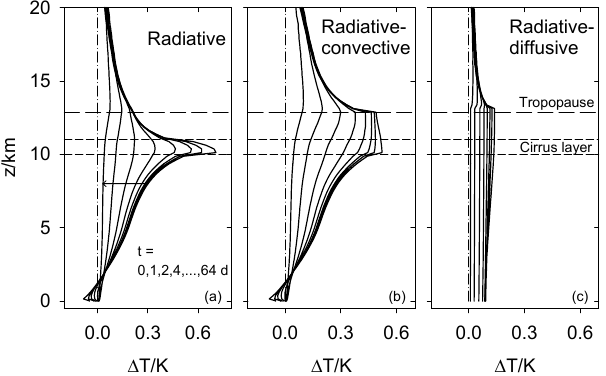
Figure 9. Decay of an initially steady-state contrail-cirrus-induced temperature increase, at times 0, 1, 2, 4, ..., 64 days after the contrail cirrus ceased, in three panels for the radiative, radiative-convective, and radiative-diffusive cases. Tropopause and contrail layer heights are indicated by dashed